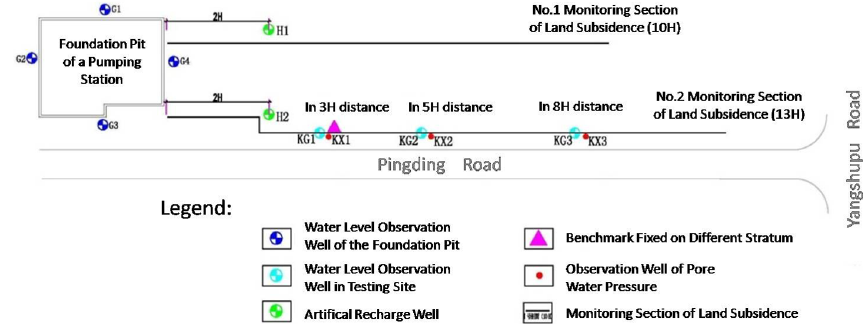
Figure 2. Layout chart of comprehensive testing site of land subsidence control in certain pumping station foundation